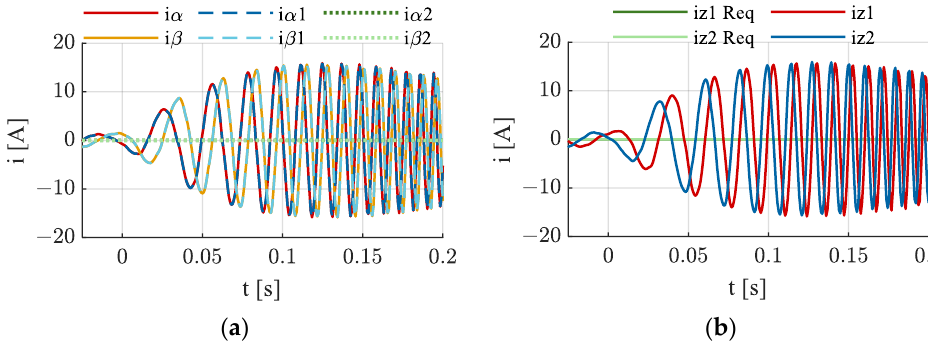
Figure 16. Current in transformed subsystems during the startup transient of the emergency three-